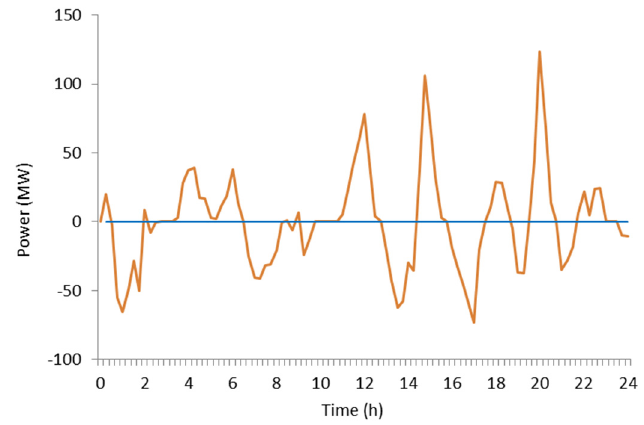
Figure 13. SLB power outputs.